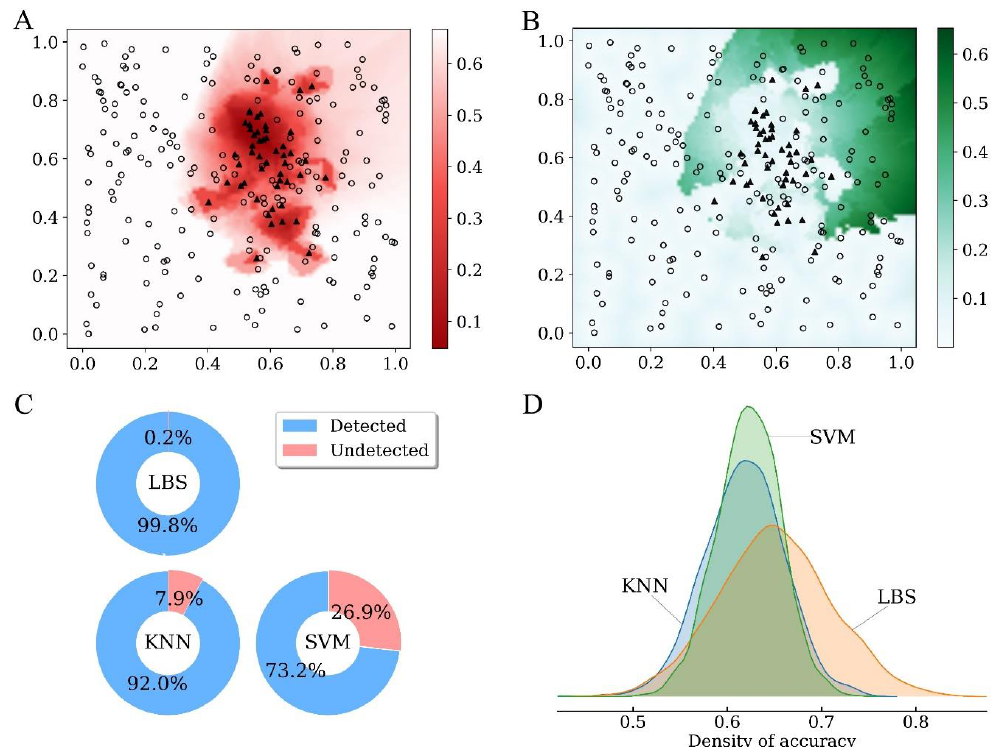
Figure 2. Performance of LBS in a simulation study. ( A ) Value of loss function for all points in raw space without feature noise. Circle, sample of negative class; Triangle, sample of positive class. ( B ) Radius of LBS for all points in raw space without feature noise. Circle, sample of negative class; Triangle, sample of positive class. ( C ) Percentage of noisy features detected by different screening approaches. ( D ) Comparison of screening accuracy on test sets. Density of accuracy was estimated on 2000 independent test sets, each of which corresponds with a trained model. KNN: K-nearest neighbors. SVM: support vector machine.